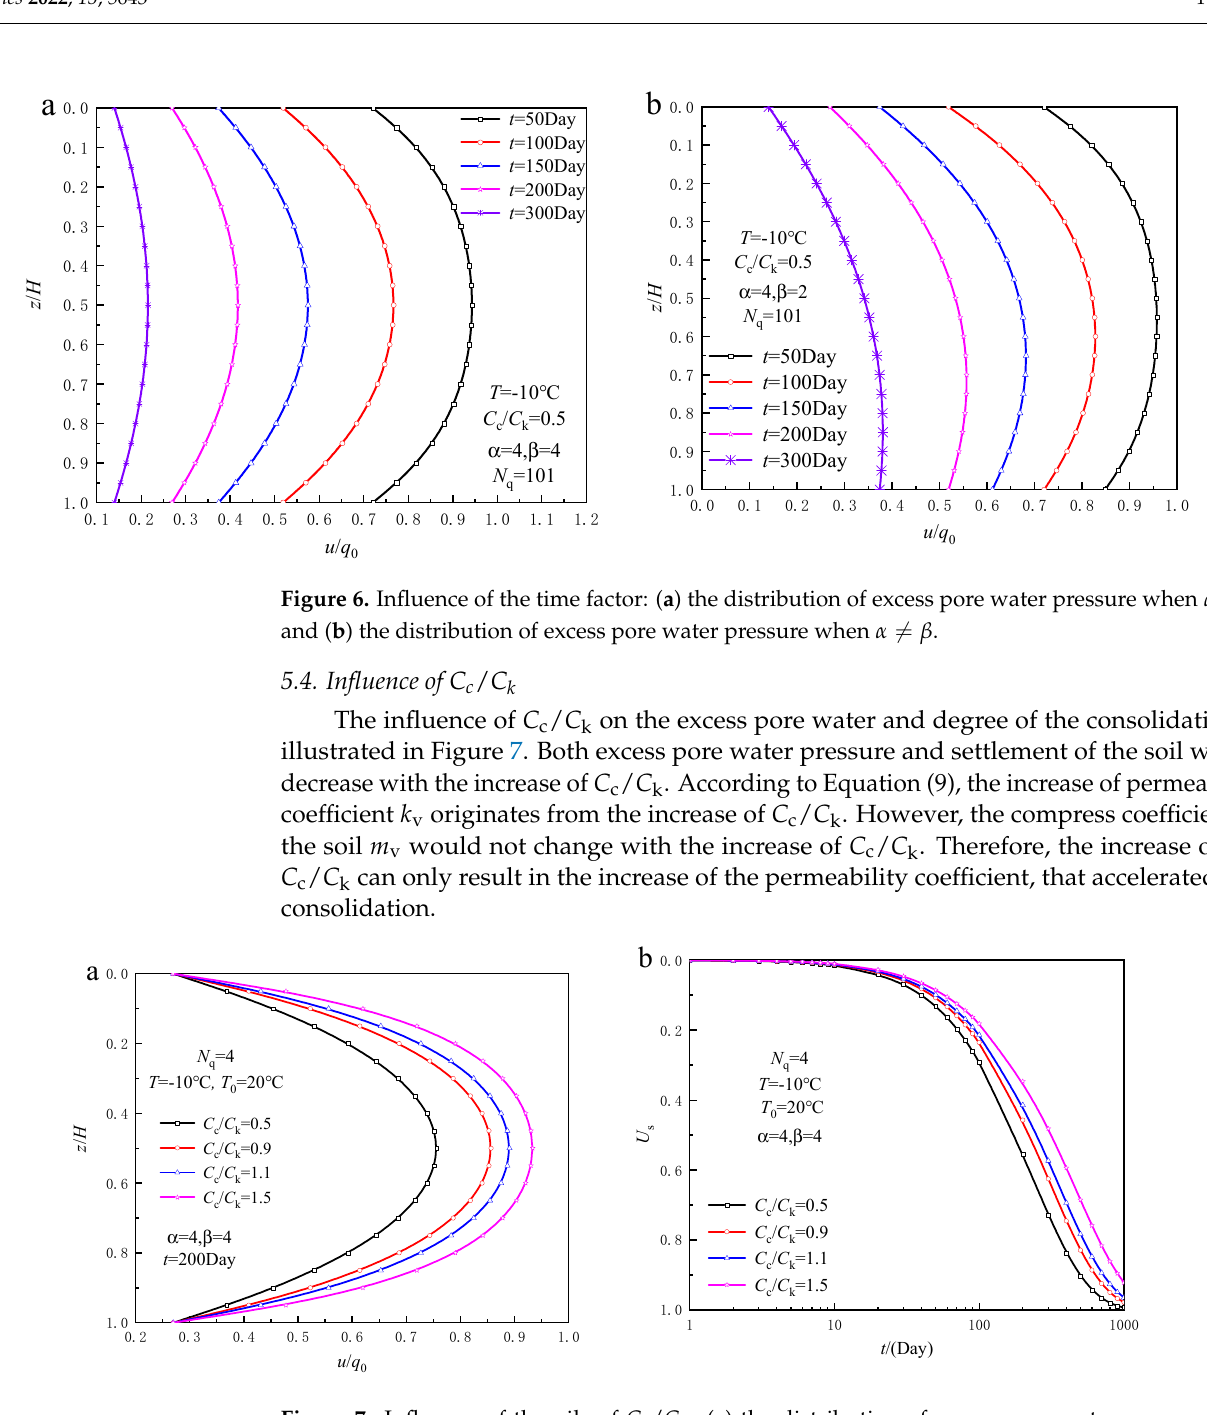
Figure 8. Influence of the interface parameters: ( a ) the distribution of excess pore water pressure, and ( b ) the distribution of the degree of the consolidation defined by settlement. 6. Conclusions In this paper, a one-dimensional nonlinear consolidation solution considering the thermal effect is derived. The main findings can be concluded as follows: (1)